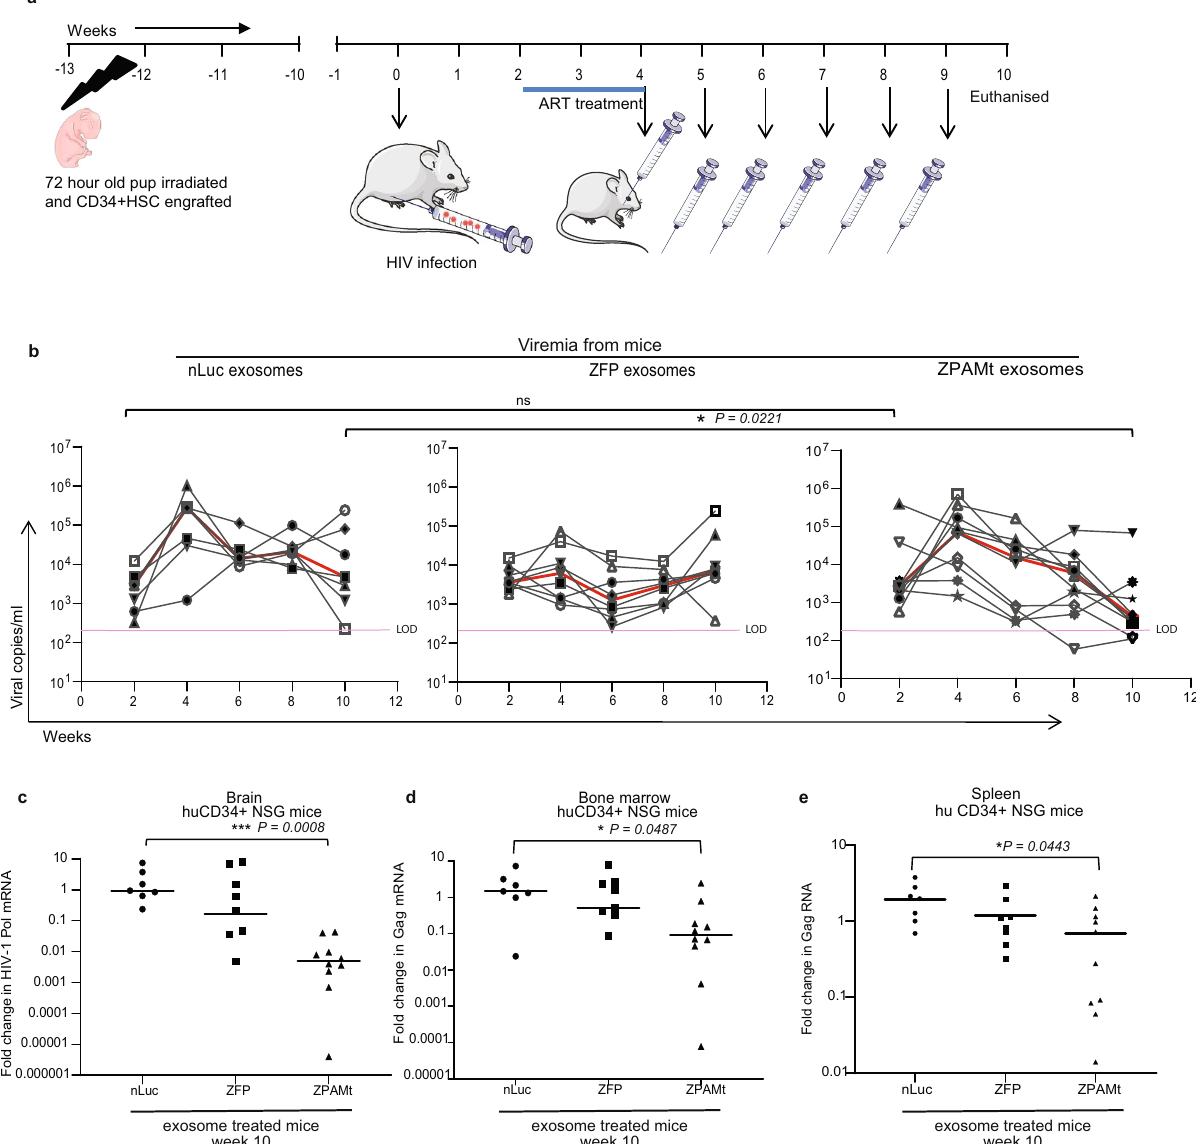
Fig. 5 Delivery of ZPAMt and decline in HIV-1 reservoir in the brain of HIV-1 infected hu-CD34 + NSG mice. a Schematic, illustrating the experimental plan to check the ef fi cacy of ZPAMt exosomes in controlling HIV-1 infection progression in hu-CD34 + NSG mice. b Dynamics of viremia in hu- CD34 + NSG mice after treatment with either nLuc exosomes (left), ZFP exosomes (center), ZPAMt exosomes (right) over the course of 10 weeks of infection and treatment as measured by RT-qPCR. Trendlines in red indicate the median of viral load. The pink line indicates LOD. c Whole-brain obtained after euthanizing HIV-1-infected hu-CD34 + NSG mice were subjected to formalin fi xation and were paraf fi n-embedded. RNA was extracted from 10 micron thick slices from FFPE brain and RT-qPCR for Pol RNA using a Taqman probe was performed to determine the level of HIV-1 Pol mRNA in the brain of nLuc, ZFP, and ZPAMt exosome-treated mice. d , e RT-qPCR for Gag RNA from an equal amount of RNA from ( d ) bone marrow lysate ( e ) spleen tissue lysate from hu-CD34 + NSG mice of nLuc, ZFP, and ZPAMt exosomes treated mice. The line shows the median value in c – e . For b – e n = 7 were used for nLuc treated mice, n = 8 for ZFP treated mice and n = 10 for ZPAMt treated mice. For b , d Kruskal – Wallis test was performed to calculate P value, for c , e P value was determined by Kruskal – Wallis test followed by Dunn ’ s post hoc test for multiple comparisons. Source data are provided in a source data fi le. Methods standard oligo cloning methods. The following reagent was obtained through the Plasmids . Mammalian expression vector pcDNA3.1 + was used to express proteins NIH HIV-1 Reagent Program, Division of AIDS, NIAID, NIH: Human Immu- node fi ciency Virus 1 (HIV-1-1) NL4-3 BaL Infectious Molecular Clone (p81A-4), ZFP362 ZFP362-DNMT3A or ZFP362-DNMT3A derived fusion constructs. For ARP-11440, contributed by Dr. Bruce Chesebro 55 . The sequences of all gBlocks, creating pcDNA-ZFP362-DNMT3A, the truncated and fusion constructs were oligos, and vectors are provided in Supplementary Data 1. ordered as gBlocks ® (Integrated DNA Technology) and cloned into a pcDNA3.1( + ) mammalian expression vector, digested with AfeI and Acc65I, using the NEBuilder ® HiFi DNA Assembly Master Mix according to the manufacturer ’ s instructions (New England Biolabs). EXOtic device plasmids pDB60 (booster), Cell culture and transfection . The HEK293T and immortalized Mesenchymal pDB68 (Connexin43 S368A), pSA465 (CD63-L7Ae) and pSA462 (nanoluc-C/D box ) stem cells (MSC) were cultured in Dulbecco ’ s modi fi ed Eagle ’ s medium (DMEM) was a kind gift from Dr Martin Fussenegger. 21 . The C/D box was introduced in the (Thermo Fisher Scienti fi c) supplemented with 10% fetal bovine serum (FBS) 3 ’ UTR of ZFP362 and ZFP362-PAMt digested with Acc65I and NotI through (GeminiBio) and incubated at 37°C and 5% CO 2 . Immortalized MSCs expressing NATURE COMMUNICATIONS| (2021) 12:5541